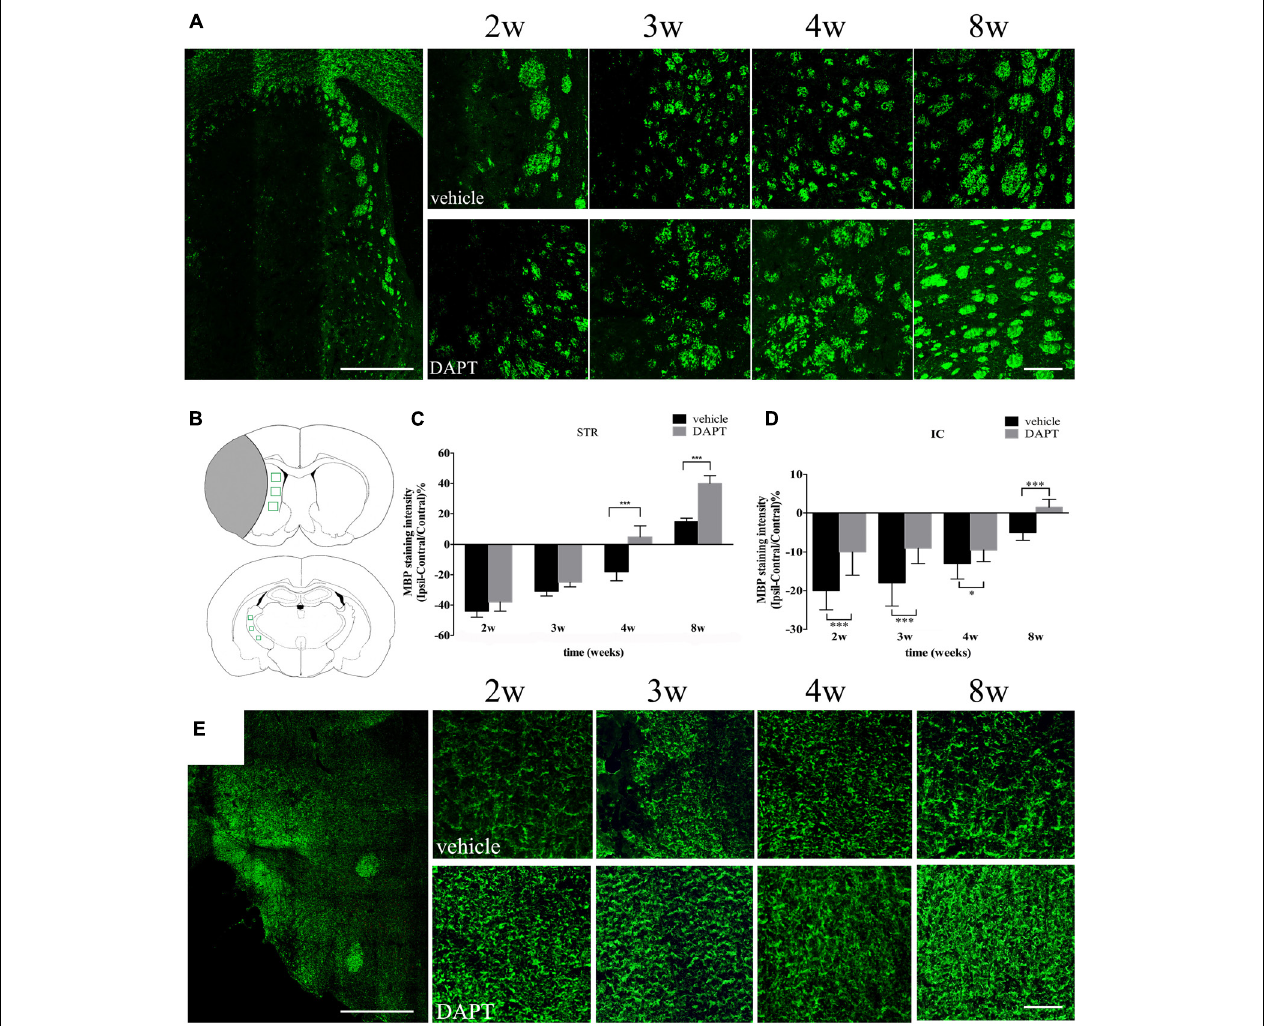
FIGURE 9 | Effects of DAPT on MBP immunoreactivity of STR and IC after MCAO. (A) The “photoemrged” image shows the location of MBP (+) cells in the ipsilateral STR. Immunostaining of MBP in ischemic boundary of STR in two group rats from 2 to 8w. Scale bar = 100 and 20 µ m. (B) Anatomical references show ROIs in ipsilateral STR and IC respectively. (C) Comparisons of MBP fluorescence intensity of ischemic boundary of STR in two group rats. ∗∗∗ P < 0.001, 4w, 8w versus DAPT and vehicle. (D) Comparisons of MBP fluorescence intensity of ipsilateral IC in two group rats. ∗∗∗ P < 0.001, 2, 3, 8w; ∗ P < 0.05, 4w versus DAPT and vehicle. (E) The “photoemrged” image shows the location of MBP (+) cells in the ipsilateral IC. Immunostaining of MBP in ipsilateral IC in two group rats from 2 to 8w. Scale bar = 100 and 20 µ